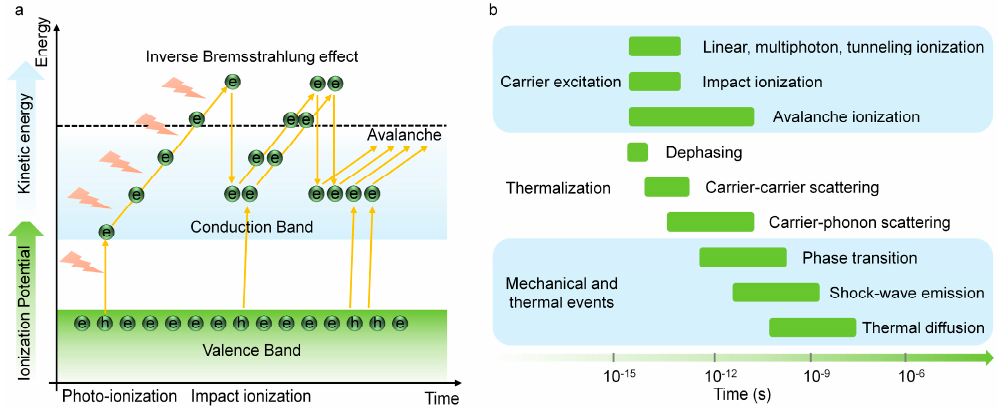
Figure 15. Femtosecond laser-induced plasma in solid. ( a ) Schematic diagram of photoionization, inverse bremsstrahlung effect, impact ionization, and avalanche ionization during the plasma gen- eration. ( b ) Timescale of the physical phenomena that are associated with the interaction between femtosecond laser and solid.